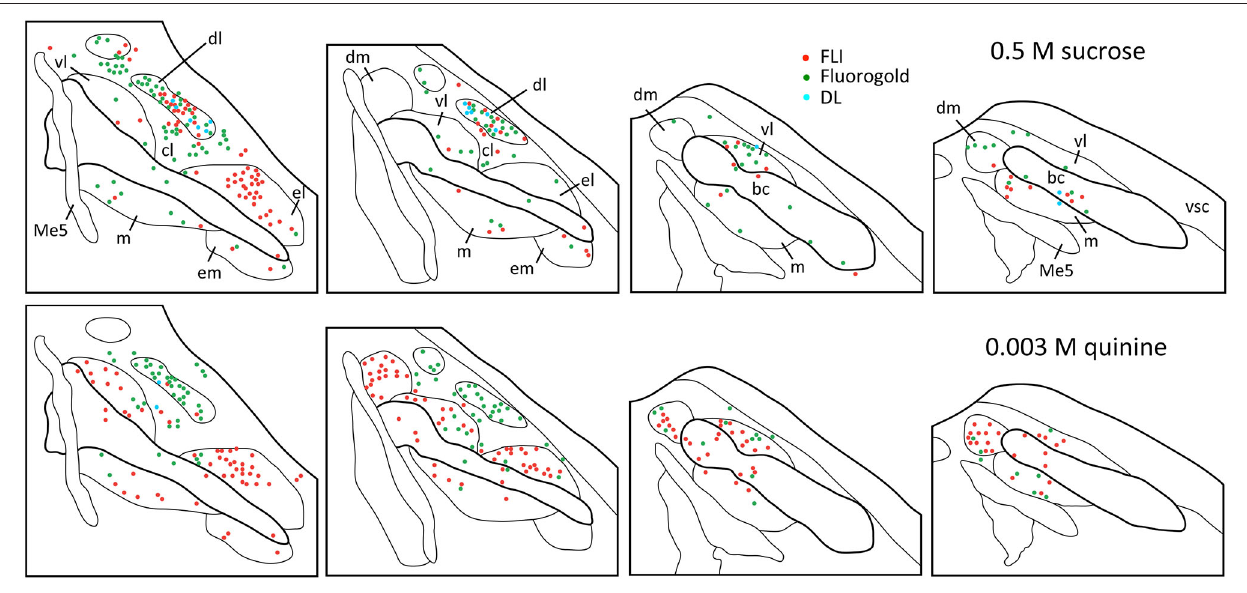
are organized from rostral (left) to caudal (right), and spaced approximately 80 µ m apart. Each set of plots was constructed from a single mouse. Me5, mesencephalic trigeminal nucleus; vsc, ventral spinocerebellar